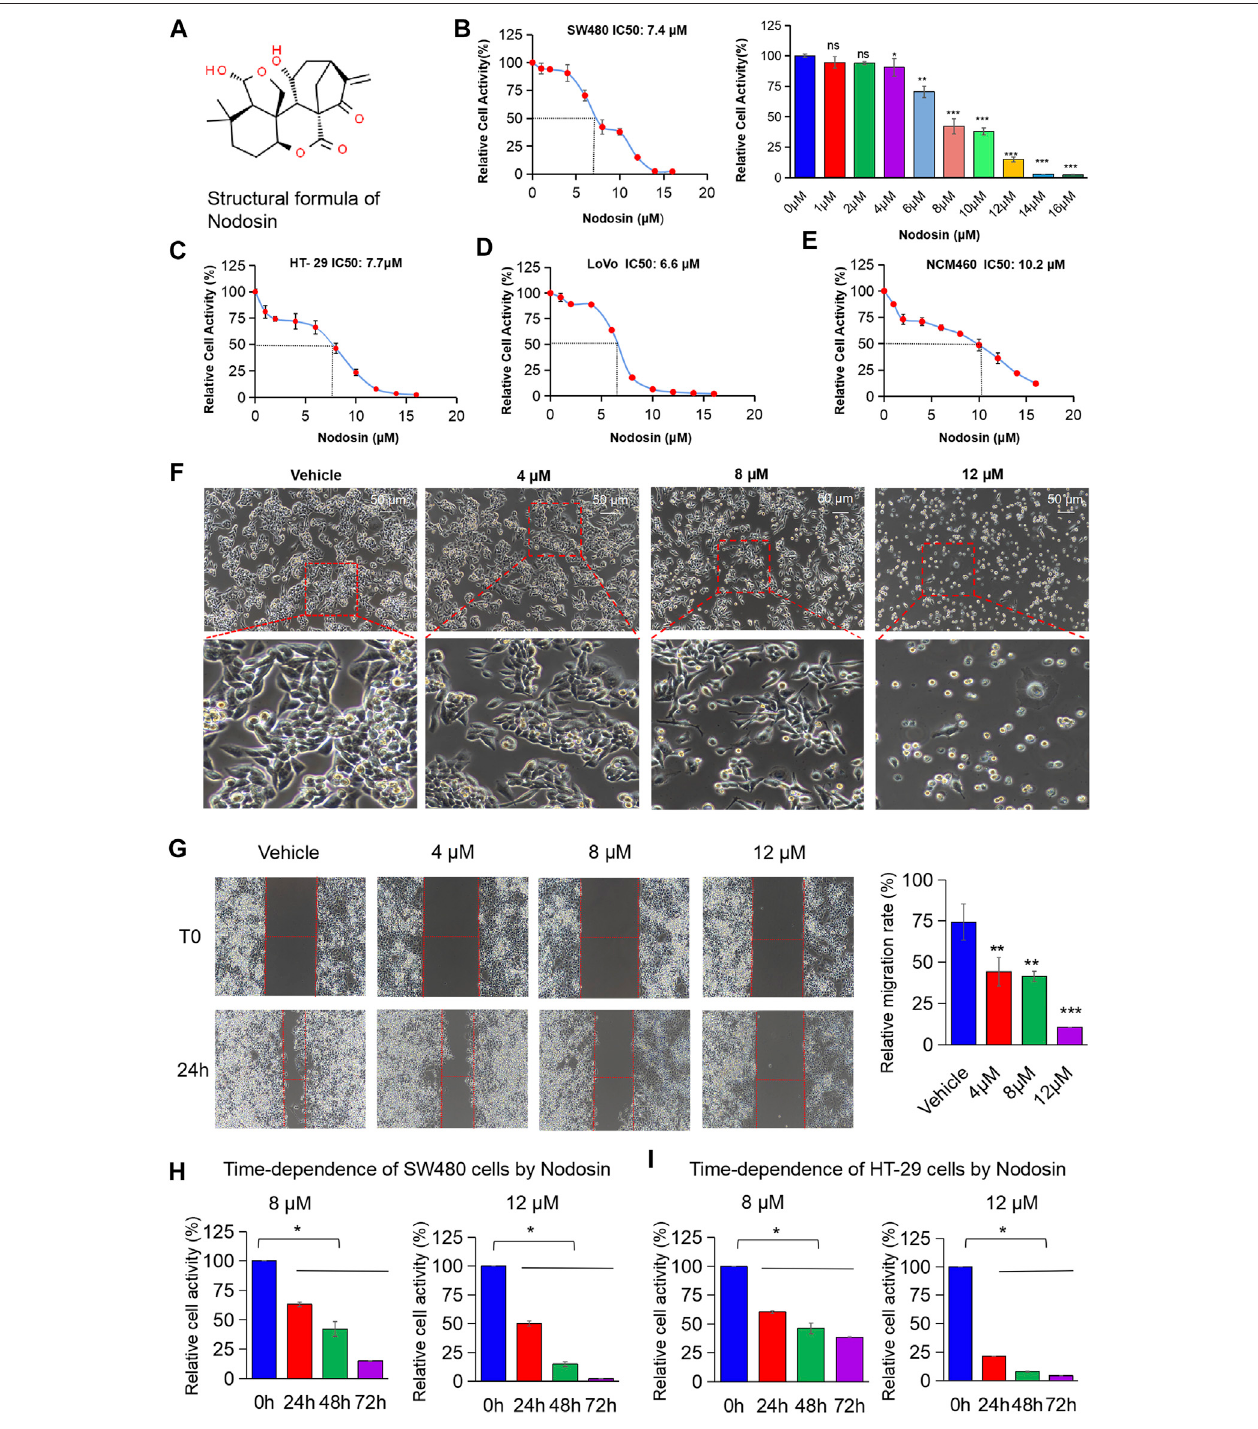
FIGURE 1 | Nodosin suppressed CRC cells in dose- and time-dependent way in vitro . (A) The chemical structural formula of nodosin (http://www.chemspider. com). (B) CRC SW480 cellswere treated with 0 – 16 μ M nodosin for 48 h. The relative viabilityofcells was detected by CCK-8 kit. Each group wasrepeated three times. The signi fi cant difference between the nodosin treated and control group (without nodosin) was evaluated by the two-tailed t -test, * p < 0.05, **0.01 < p < 0.05, *** p < 0. 01. (C) HT-29 cells were treated with 0 – 16 μ M nodosin for 48 h. The cell viability was tested by CCK-8 kit. (D) LoVo cells were treated with 0 – 16 μ M nodosin for 48 h.Thecellviabilitywastested byCCK-8kit. (E) NCM460 cellsweretreatedwith0 – 16 μ Mnodosin for48 h. ThecellactivitywastestedbyCCK-8 kit. (F) SW480cells were treated with nodosin for 48 h, and the morphological changes of SW480 cells were recorded by fl uorescence inverted microscope. (G) The repressive effect of